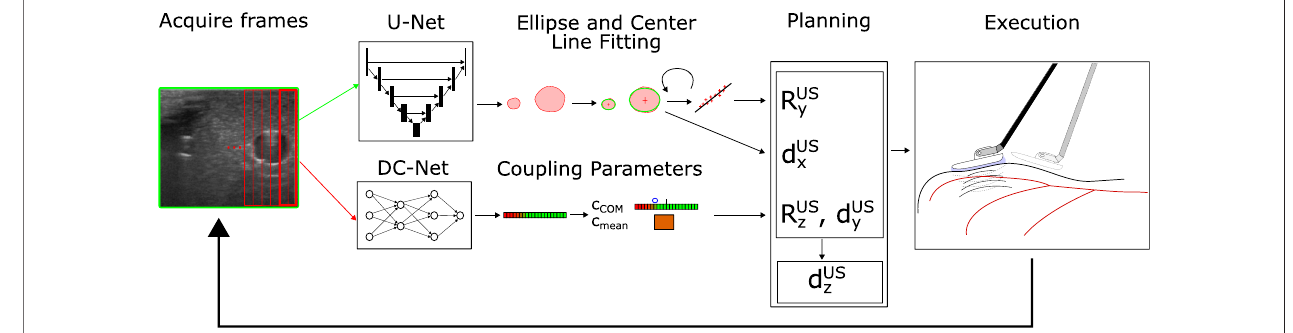
FIGURE1| SystemStructure:ThecurrentUSframeisacquiredandfedintoU-Net(entireimage)andDC-Net(overlappingimageslices).Thesegmentationresults of the U-Net are post-processed, and ellipses are fi tted around segmentation patches likely to correspond to vessels (upper path). The current vessel center is used to performin-planemovements( d x )tocenterthevesselwithintheimage.Recognizedvesselcentersfrompreviousframesarebufferedandusedtoestimatethecenterline and reorient the image normal R US y (rotation around y US - see also Figure 3 ). The parallel path with the outputs from the DC-Net are compressed into coupling parametersthatareusedtoadaptrotationaroundtheimagenormal( R z )andcompressionmovements( d y ).Iftheprobealignmentwiththevesselandcouplingisproperly adjusted, the probe is progressed forward in the image plane normal direction ( d z